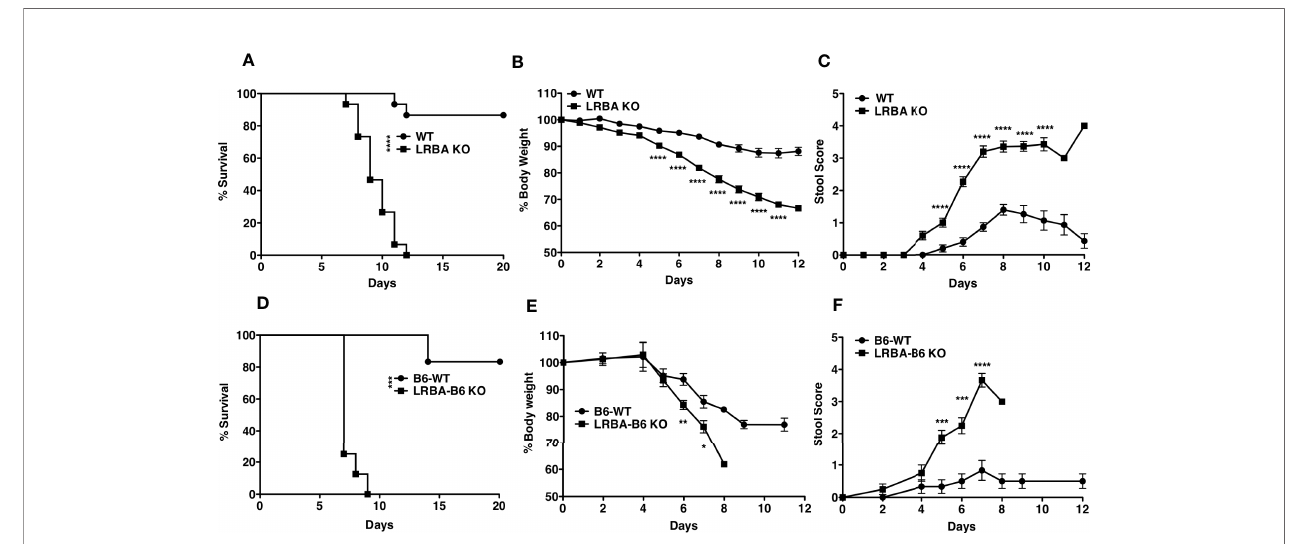
FIGURE 3 | Susceptibility to colitis observed in LRBA KO mice is non-transmissible. WT and LRBA KO (129Sv background) mice co-housed for 2 months received 3% DSS for 7 days. (A) Survival, (B) % weight loss, and (C) stool score. Pooled data from 2 independent experiments n = 15. WT and LRBA KO littermates on a C57BL6 background (F7 backcross) received 3% DSS for 7 days. (D) Survival, (E) weight loss, and (F) stool score. *p < 0.05, **p < 0.01, ***p < 0.001, ****p < 0.0001. KO, knockout; DSS, dextran sulfate sodium; WT, wild